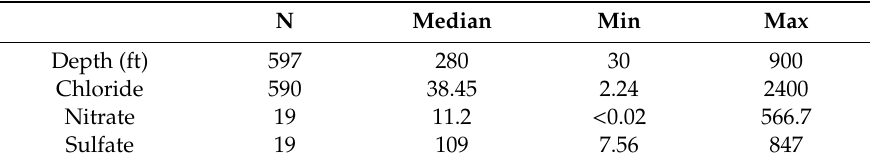
Table 5. Descriptive statistics for the wells sampled and associated parameters measured.